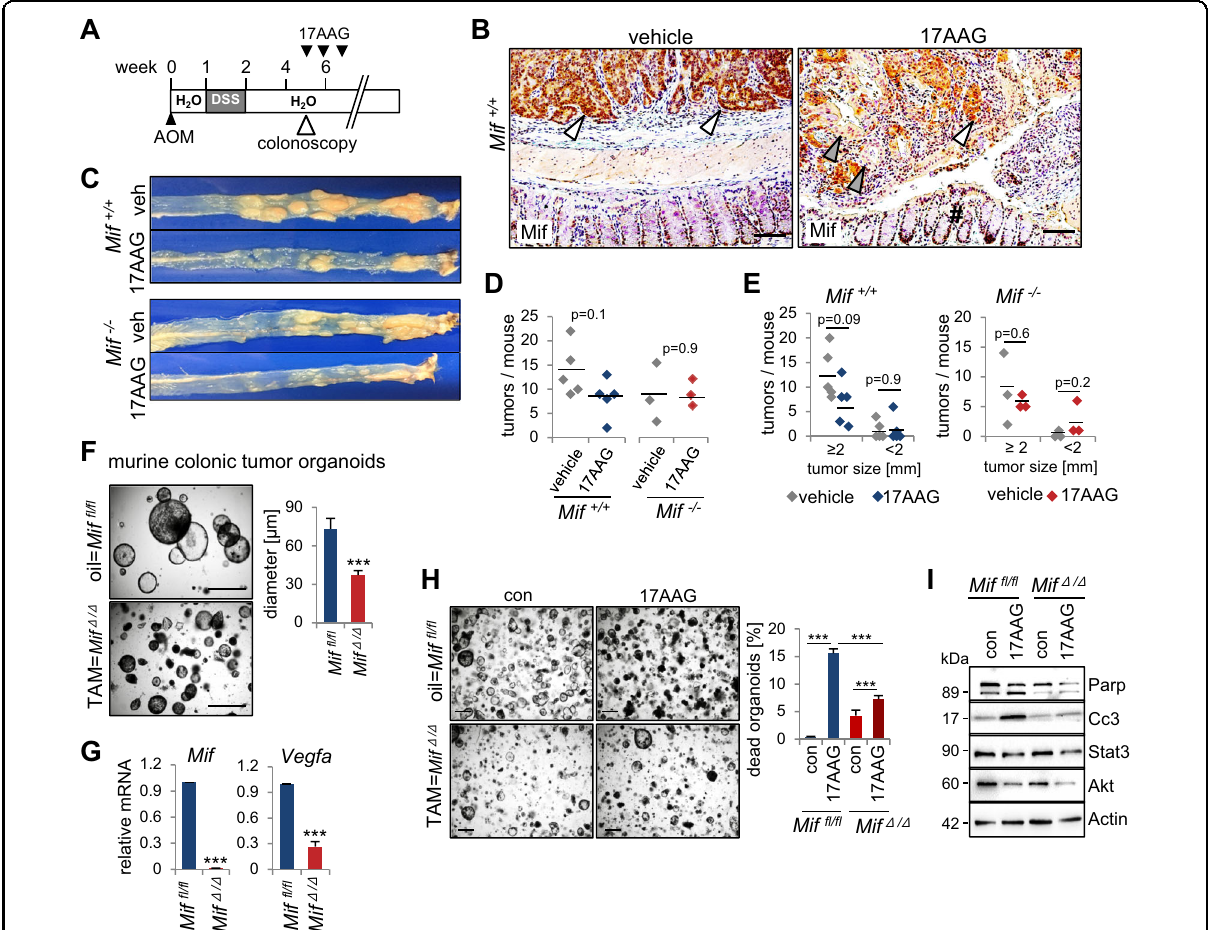
Fig. 6 MIF-driven CRC is vulnerable to Hsp90 inhibition. A Hsp90 inhibitor treatment timeline within the AOM/DSS mouse model. After tumors visualized via colonoscopy and scored as more than one S2/3 or three S1/2 tumors, mice were treated with the HSP90 inhibitor 17AAG for 3 weeks. B Representative histological Mif staining of tumor-bearing colonic tissue from Mif + / + mice after 3 weeks of 17AAG or vehicle treatment. White arrows indicate tumor epithelial cells with elevated Mif levels. Gray arrows indicate tumor cells with degraded Mif. #, normal epithelia of the next surrounding layer with low Mif levels. Scale bars, 100 µm. C Macroscopic overview of entire tumor-bearing colons from Mif + / + and Mif − / − mice after 3 weeks of treatment with 17AAG or vehicle. D Numbers of tumors per mouse as indicated in Mif + / + ( n = 5 mice per group) and Mif − / − mice ( n = 3 per group). Black lines, mean. p values with ANOVA, Bonferroni ’ s multiple comparison test, p = 0.212. E Tumor sizes of mice from (D). Indicated groups, calculated with Student ’ s t test. F Assessment of organoid growth in Mif -depleted organoids. Mif fl / fl ;villincreERT2 mice with a de fi ned tumor burden were treated with Tamoxifen (TAM) or respective vehicle control to generate Mif -de fi cient CRC tumors ( Mif Δ / Δ ) to mimic a Mif epithelial- speci fi c knockout. From those tumors, colonic tumor organoids were generated. Representative images and quanti fi cation of colonic tumor organoids (p 5) derived from oil ( Mif fl / fl ) or TAM ( Mif Δ / Δ ) treated mice. (right) At least 11 images were quanti fi ed from 10 different gel domes. Diameter of organoids was measured using ImageJ. Scale bars, 200 µm. Means ± SD from different images. G Expression analysis of Mif and Vegfa in Mif fl / fl or Mif Δ / Δ derived organoids. Via qRT-PCR, expression was co-normalized to Rplp0 and Hprt1 . Means ± SD of 4 – 5 technical replicates. H Imaging and quanti fi cation of organoid death of Mif -pro fi cient (top) and Mif -de fi cient (bottom) organoids prepared as in ( F ) after 17AAG (500 nM) for 21 h. Scale bars, 200 µm. Quanti fi cations based on organoid morphology. At least 5 images from ≥ 5 gel domes (×4 magni fi cation each) per group were counted. The percentage of dead organoids was calculated to all organoids. Mean ± SD from ≥ 6 images. I Immunoblot of organoids of ( H ) at the endpoint of the experiment. Cc3 (cleaved caspase-3) and Parp (poly(ADP-ribose)-polymerase), apoptotic markers. Stat3 and Akt, further Hsp90 clients served as positive control for 17AAG functionality. Actin, loading control. F , G , H p values, Student ’ s t tests for indicated